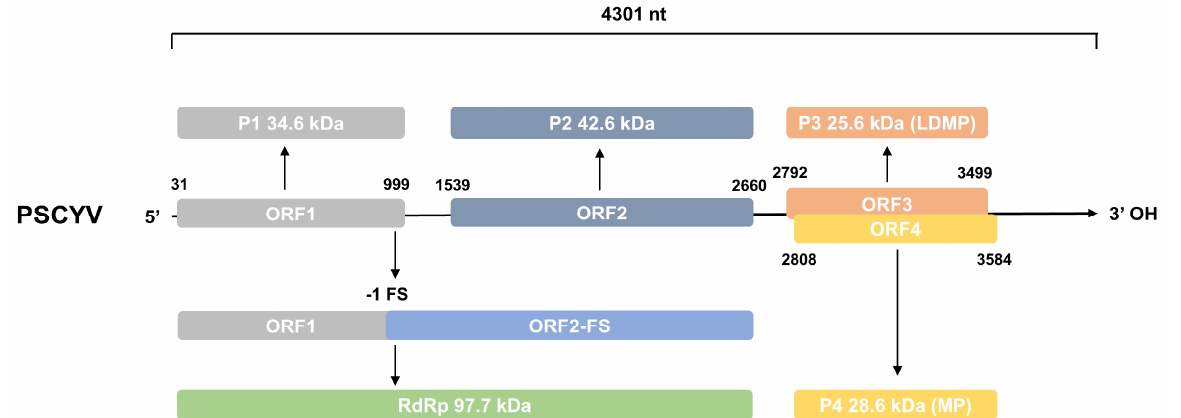
Figure 2. Schematic diagram of the PSCYV genome organization. Nucleotide position of individual protein is indicated above or under each gene box. The conserved umbraviral motifs are indicated above or under the diagram. ORF2-FS stands for ORF2 that is translated through -1 frameshift; -1 FS, -1 frameshift; RdRp, RNA-dependent RNA polymerase; LDMP, viral long-distance movement protein; and MP, viral cell-to-cell movement protein.